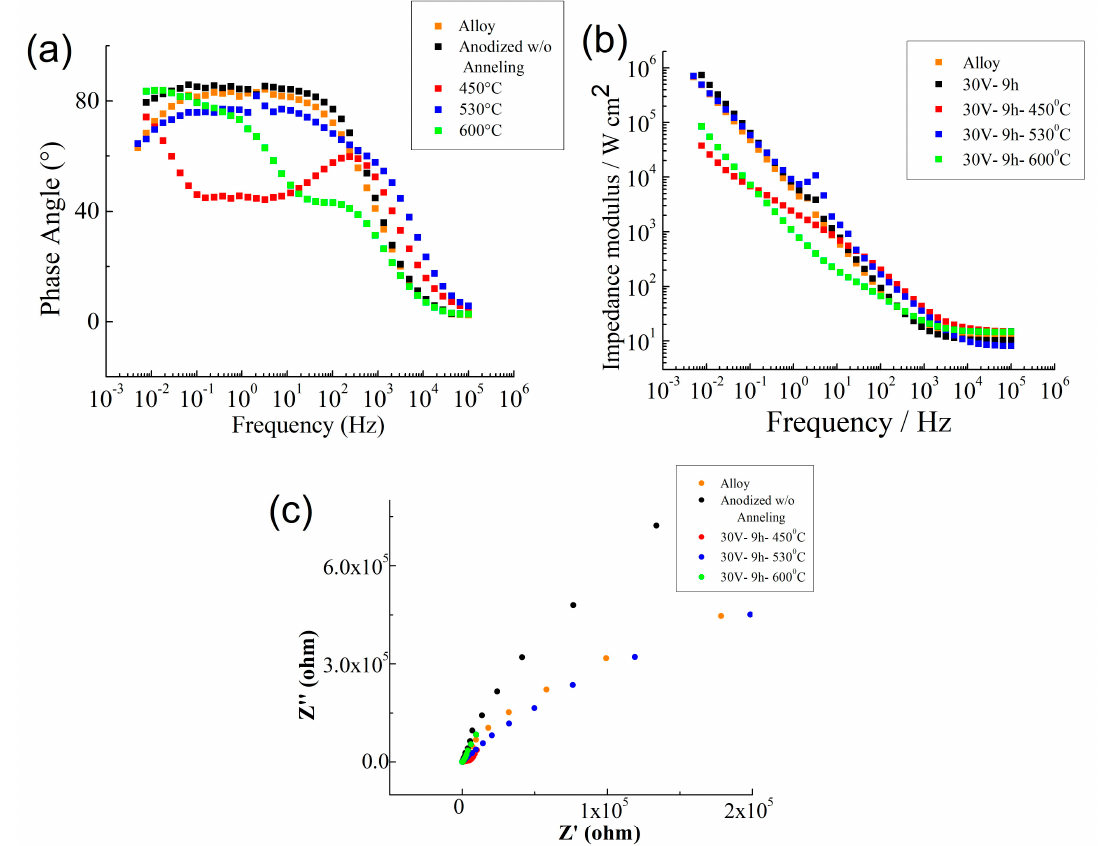
Figure 6. Impedance modulus ( a ), impedance angle ( b ) and Nyquist plots ( c ) in 0.15 M NaCl + 0.03 M NaF solution at 25 °C.